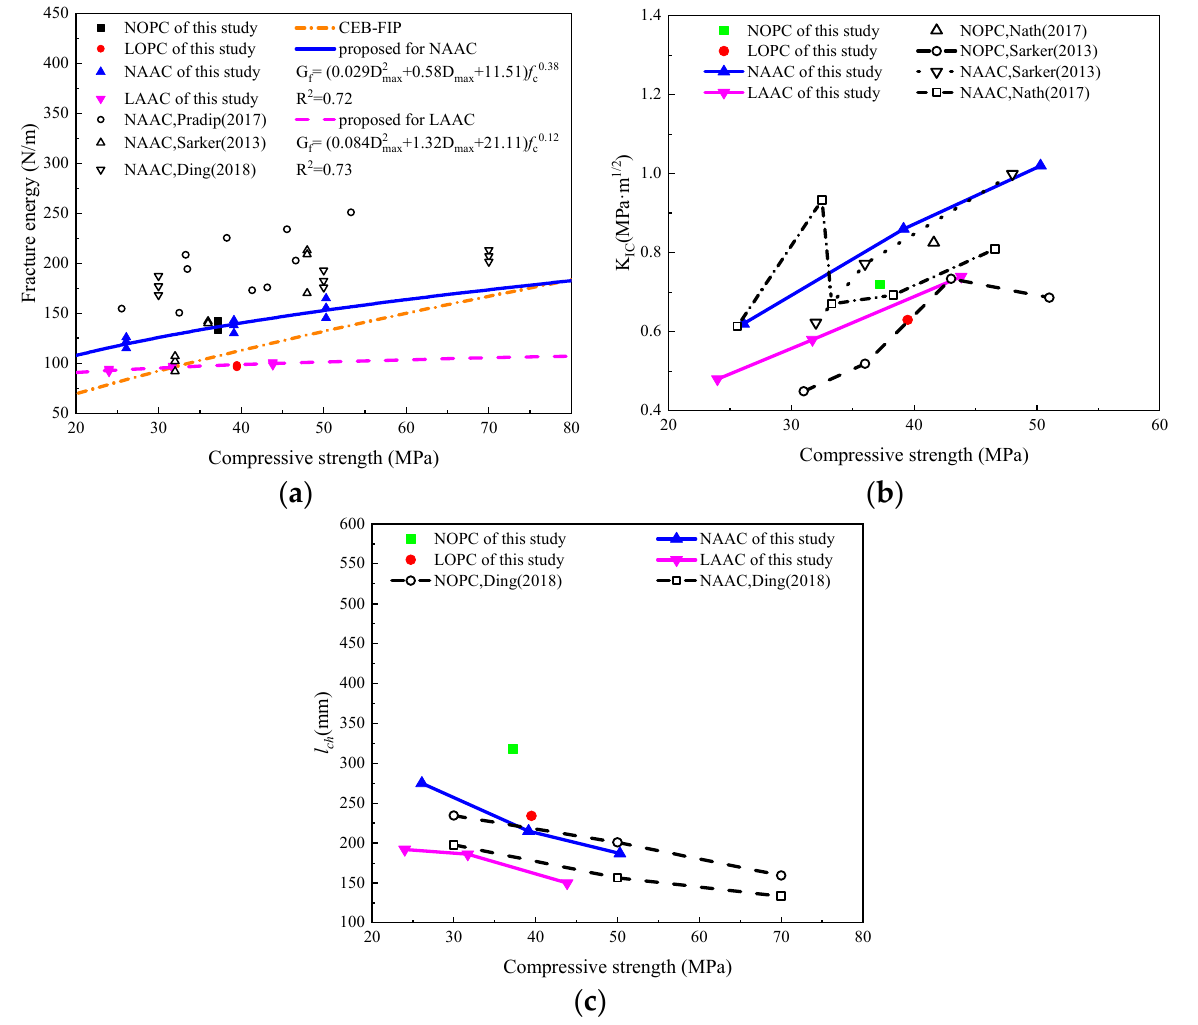
Figure 9. Relationship between the fracture parameters and compressive strength of the concretes: ( a ) fracture energy; ( b ) critical stress intensity factor; ( c ) characteristic length.